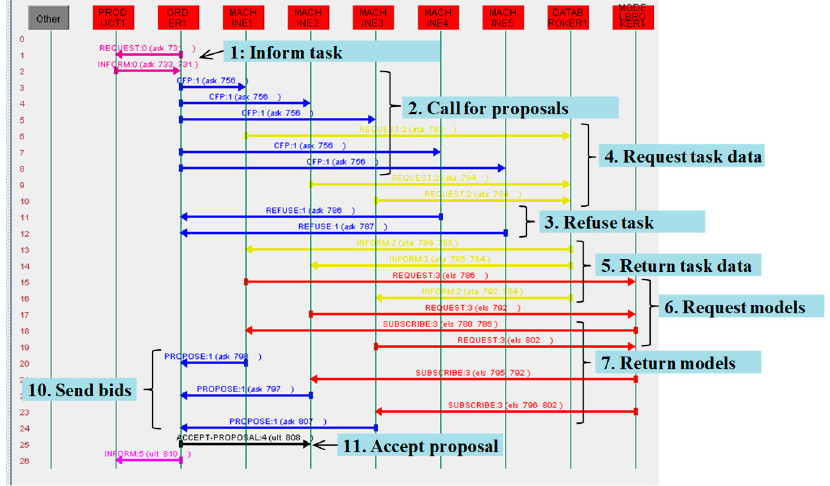
Figure 14. Implementation result: model usage and machine selection.